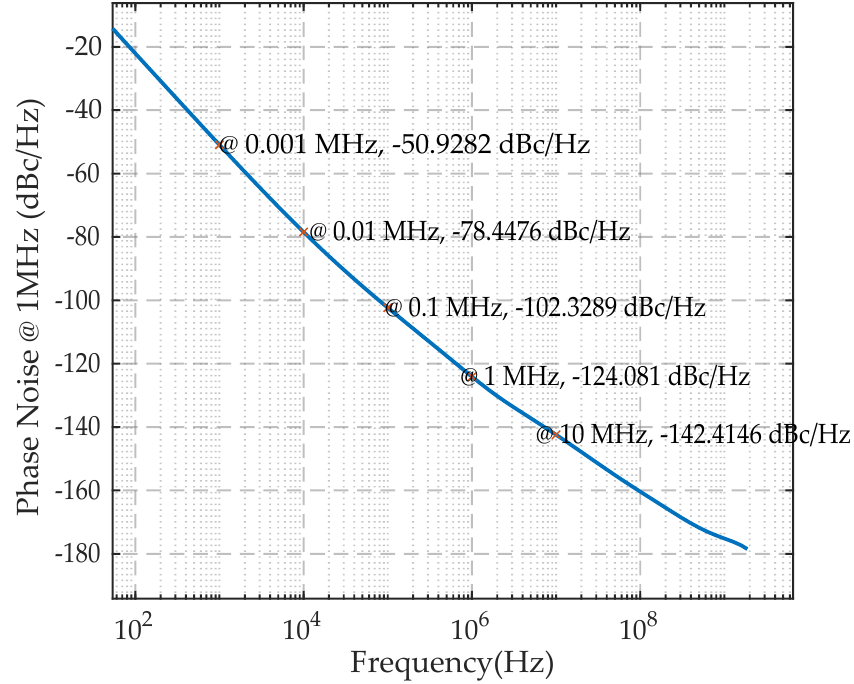
Figure 11. Post-layout simulation phase noise at NN corner and 3.717 GHz output